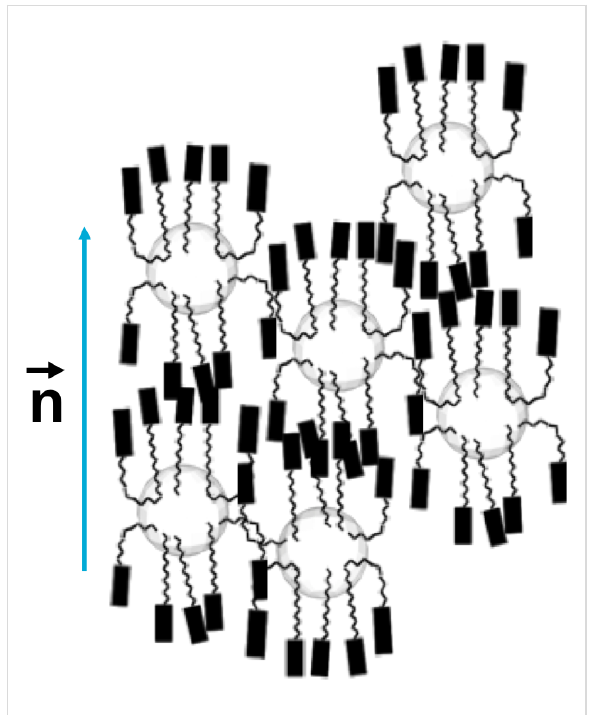
Figure 23: Model proposed for the organisation of the hybrids within the quasi-nematic mesophase. Reprinted with permission from [85]. Copyright 2010 Wiley-VCH